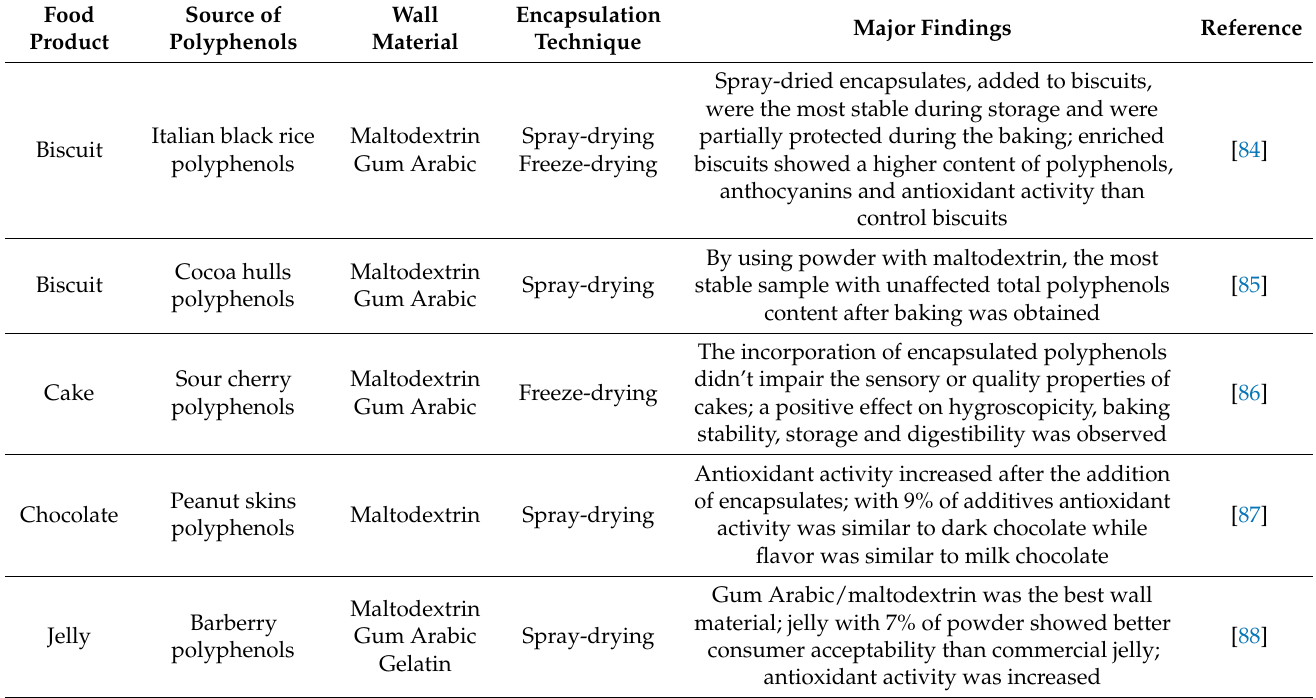
Table 4. Selected studies on the incorporation of encapsulated polyphenols into food products. Major Findings